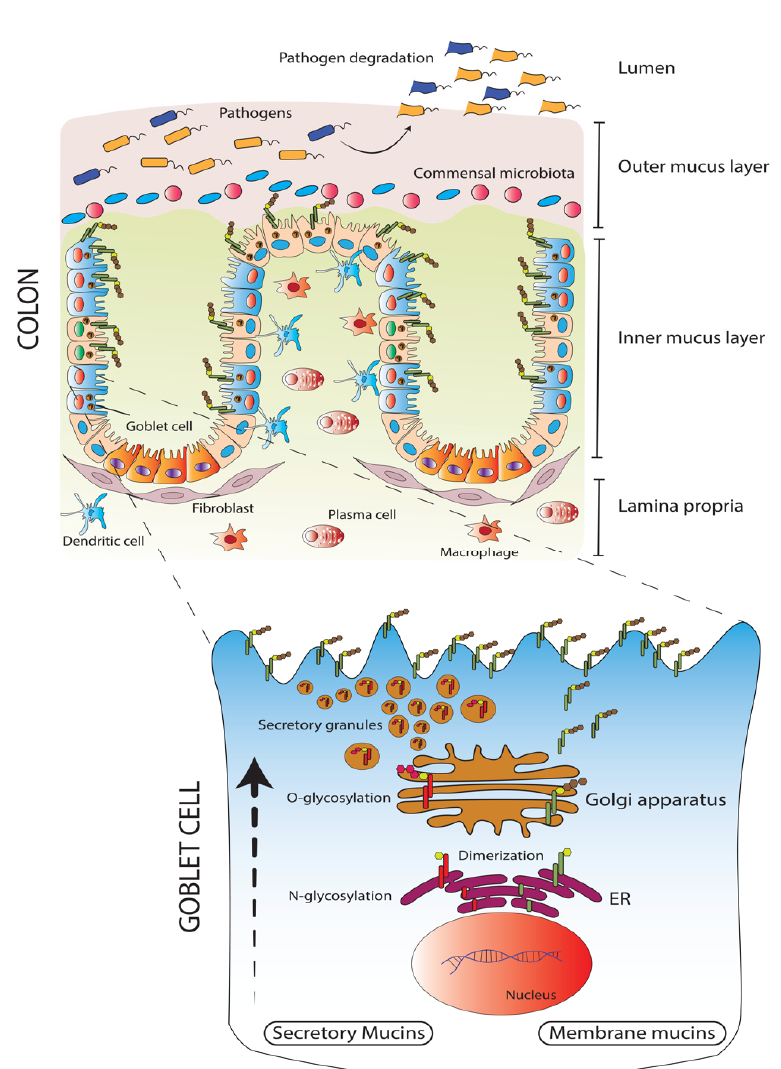
Figure 2. Schematic representing mucin synthesis and localization across colon villi. Transmembrane mucins are localized on the surface of epithelial cells while, secreted mucins (most predominately MUC2) are packed in secretory granules. In presence of low pH, degranulation occurs, and the secreted mucins are released which further undergoes concatenation and forms sheets on the outer layer of the colon epithelium. Depending on the variability of glycans on the secreted mucins, diverse commensal bacteria colonize the outer layer of the colon while the inner layer of the epithelia is impenetrable. Owing to the symbiotic association between MUC2 sheets and commensal bacteria, pathogenic bacteria get expelled; thus, loss of secreted mucins render the inner epithelia vulnerable to pathogenic infiltration. Enlarged is a goblet cell where the membrane-bound and secreted mucins following translation, undergoes post-translational modification in the Endoplasmic Reticulum (ER) and Golgi apparatus. Dimerization and N-glycosylation of the mucins occur in the ER followed by O-glycosylation in the Golgi and then they are either packed in secretory vesicles or targeted to the